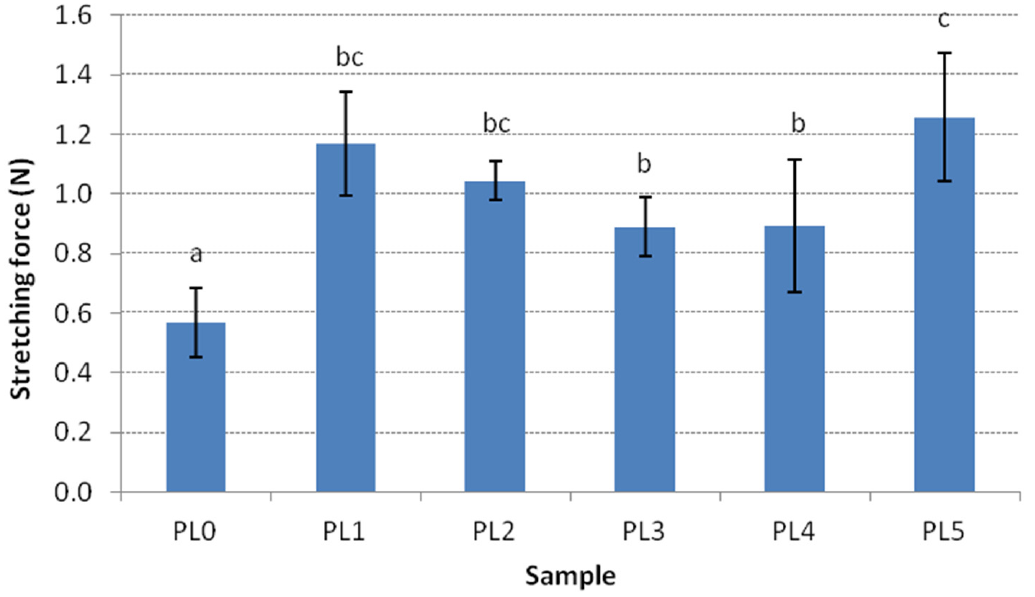
Figure 1. Changes in stretching force (N) with respect to GL enrichment. PL0, PL1, PL2, PL3, PL4, and PL5 denote pasta with 0, 1, 2, 3, 4, and 5 g/100 g of green leek, respectively. Values followed by the same letter (a–c) are not significantly different ( p < 0.05), n = 5.